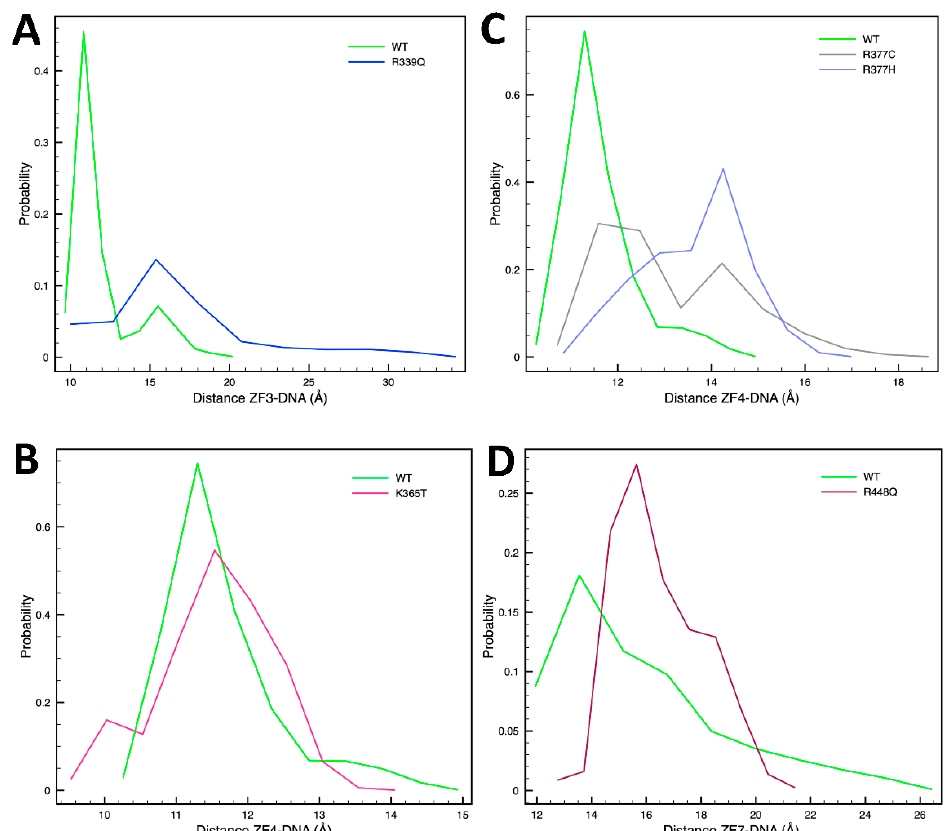
Figure 6. Single-residue mutations affect the interaction between the α -helix of specific ZFs and the DNA. Shown is the probability distribution for the distance between the center of mass of a ZF’s α -helix and the DNA for: ( A ) ZF3 of WT vs. R339Q, ( B ) ZF4 of WT vs. R337C/H, ( C ) ZF4 of WT vs. K365T, and ( D ) ZF7 of WT vs. R448Q. Distributions are calculated using the last 100 ns of each of the five trajectories per system.